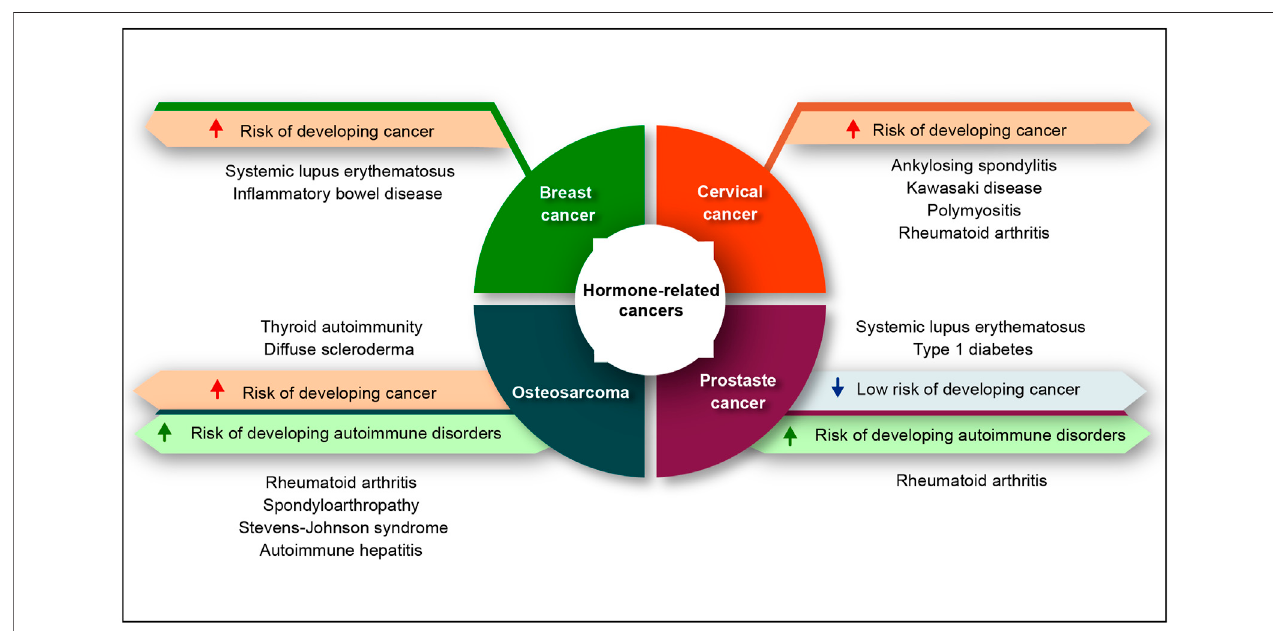
FIGURE1| Therelationshipbetweenautoimmunedisordersandhormone-relatedcancers.Theredarrowsrepresentanincreasedriskofcancer,thegreenarrows represent an increased chance of autoimmune illness, and the blue arrows represent a lowered risk of cancer.